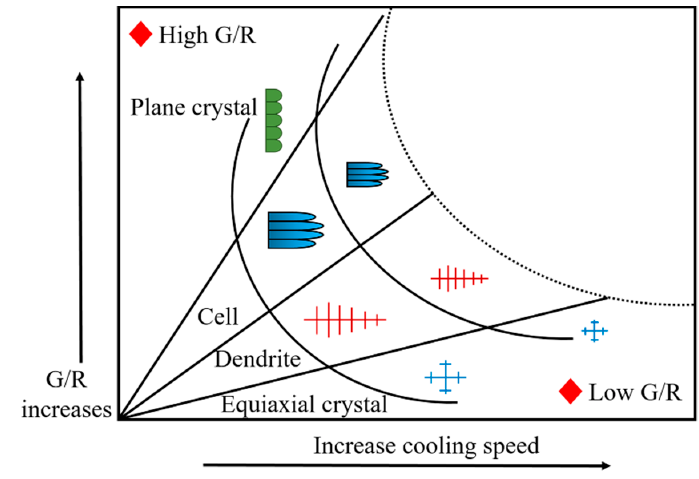
Figure 5. Grain growth at the coating bottom.